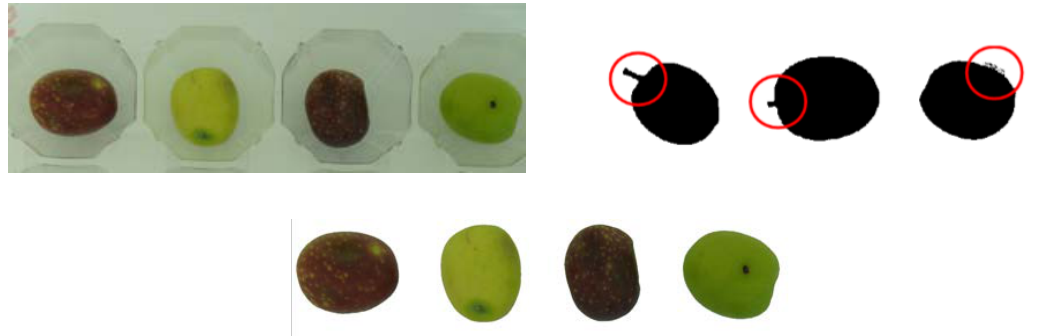
Figure 2. ( Left ) Original images of a group of olives inside a tray; ( Right ) Black/white image with three defective olives. ( Bottom centre ) Final segmentation of group olives.